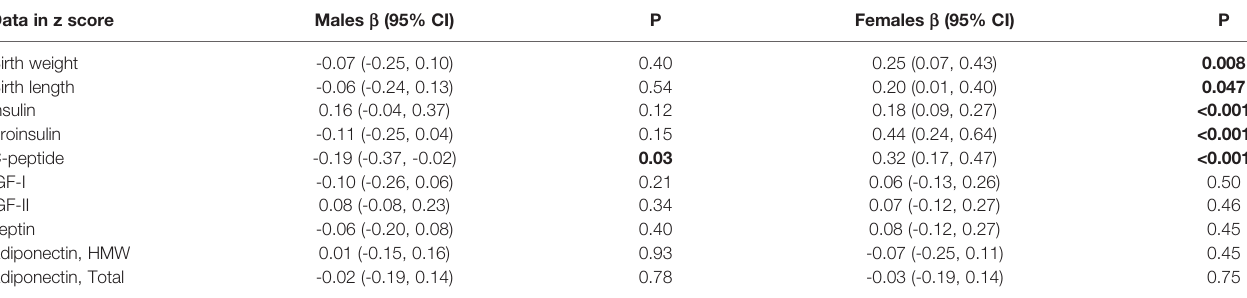
TABLE 4 | The adjusted associations of cord blood FGF19 with birth weight, birth length, insulin, proinsulin, C-peptide, IGF-I and IGF-II, leptin and adiponectin in males and females. Data in z